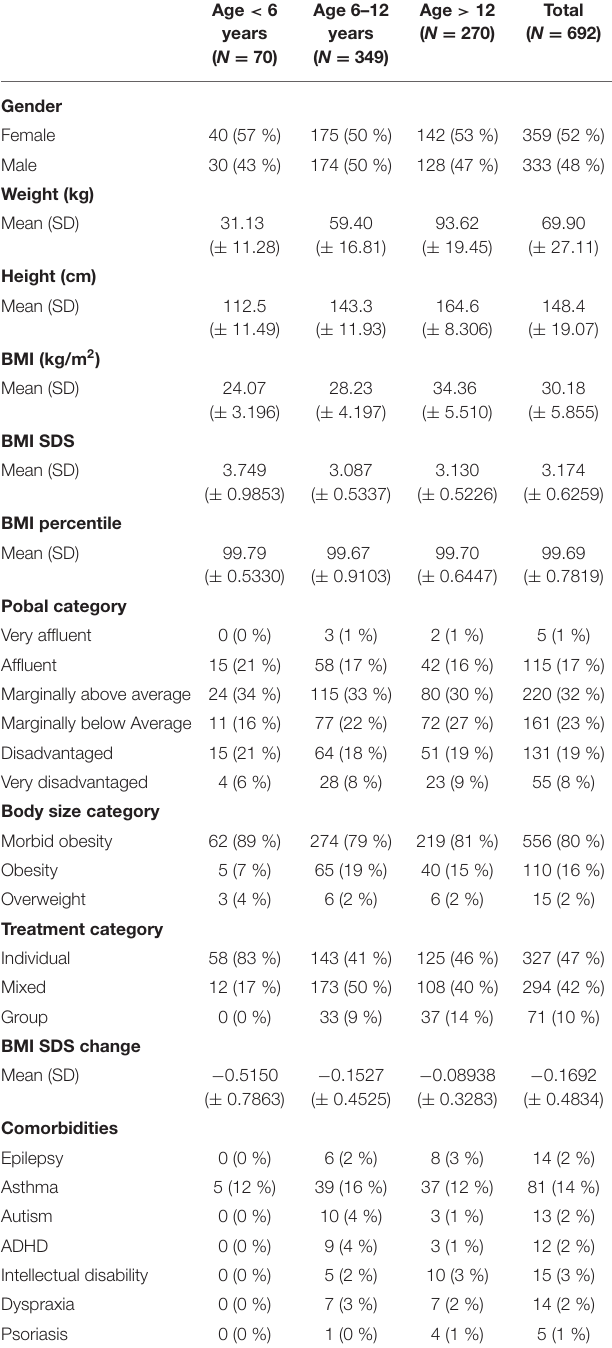
TABLE 2 | Demography and clinic presentation data for study participants. TABLE 3 | Multiple linear regression analysis of the association between change in SDS-BMI and demographic